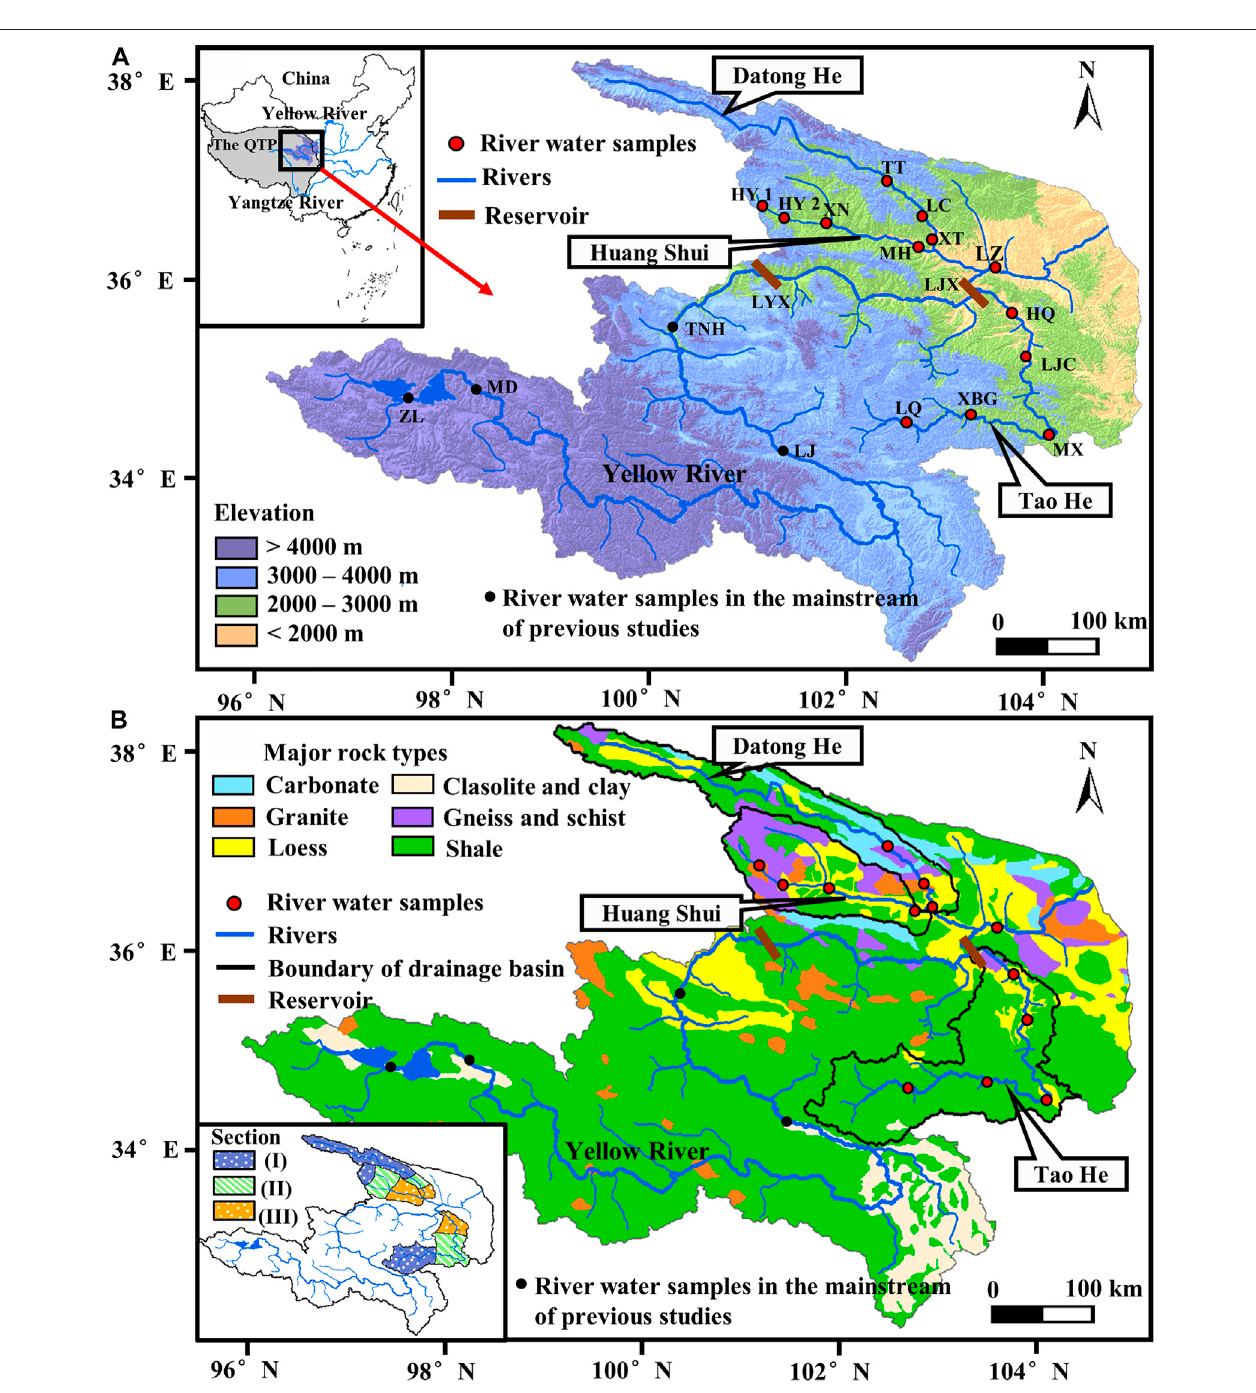
FIGURE 1| (A) Elevation map and (B) Geological map of the Tao He, Huang Shui, Datong He, and Yellow River QTPsub-basin (upstream ofthe Lanzhou station). Elevation data were taken from https://srtm.csi.cgiar.org/srtmdata/. The geological map is modi fi ed from Chen et al. (2005), with reference to Pang et al. (2018) for details. Yellow River:TNH, Tangnaihai; GD, Guide; LZ, Lanzhou; Tao He: LQ, Luqu; XBG, Xiabagou; MX, Minxian; LJC, Lijiacun; HQ, Hongqi; Huang Shui: HY1, Haiyan; HY2,Huangyuan;XN,Xining;MH,Minhe;DatongHe:TT,Tiantang;LC,Liancheng;XT,Xiangtang.TheinsetinpanelBshowsthestudyareadividedintothe(I)QTP sections(thedrainagebasinsupstreamXiabagouoftheTaoHe,HaiyanoftheHuangShui,andTiantangoftheDatongHe),(II)thetransitionzonesbetweentheQTPand the LP (Xiabagou to Lijiacun of the Tao He, Haiyan to Xining of the Huang Shui, Tiantang to Liancheng of the Datong He), (III) the LP sections (the drainage basins downstream Lijiacun of the Tao He, Xining of the Huang Shui, and Liancheng of the Datong He). The detailed latitude, longitude and elevation of the stations are in Supplementary Table S1